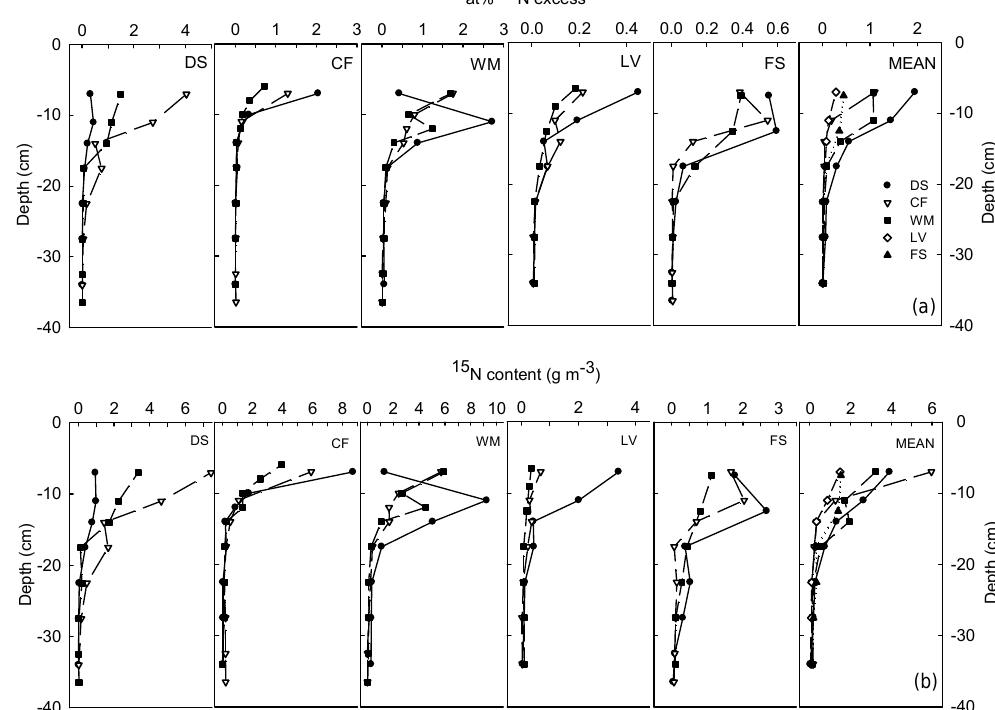
Figure 7. Depth profiles of peat at.% 15 N excess (a) and peat 15 N content (b) for three replicate cores from each site (6–9 samples per core) and the mean at.% 15 N excess and peat 15 N content for each site. The scale of the x axes varies across panels. Site abbreviations as in Fig. 1.